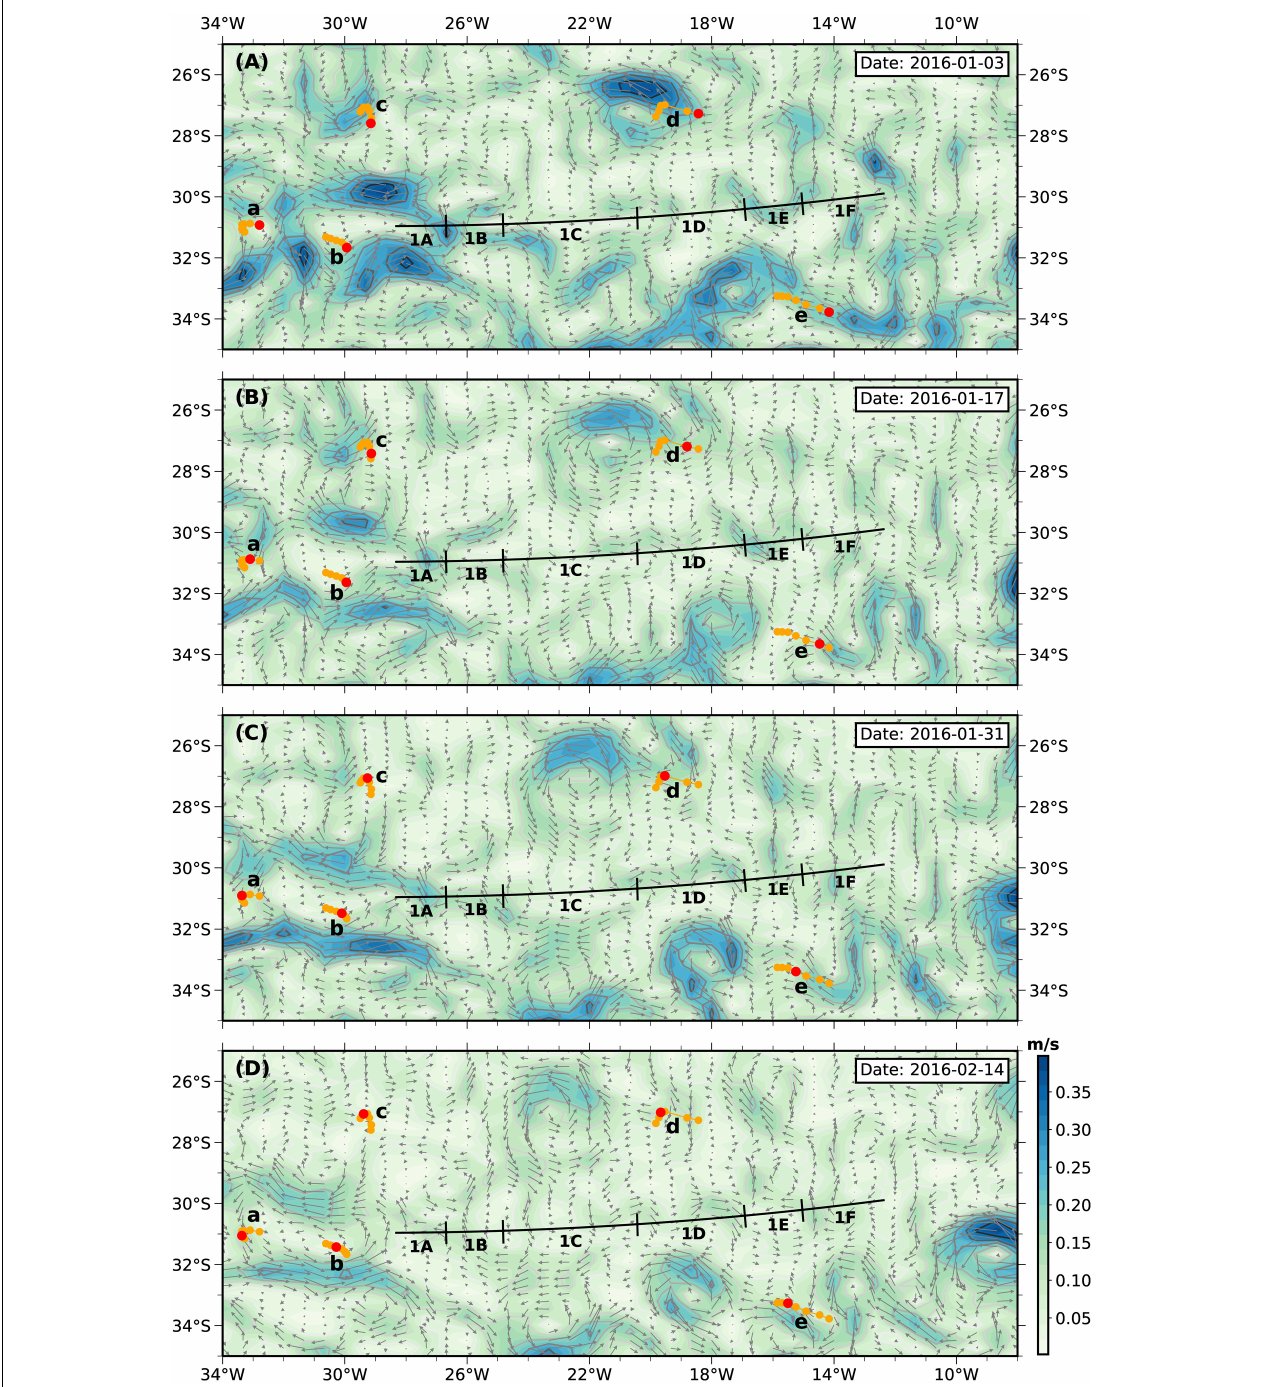
FIGURE 10 | (A) Maps of sea surface geostrophic current velocities calculated for 5 days composite centered on 2016/01/03 from Ocean Surface Current Analyses Real-time (OSCAR) satellite measurements. Black lines = seismic survey lines. Orange dots = the trajectory of the Argo floats a–e shown in Figure 1 . Red dots = the positions of the Argo floats closest to the date of the satellite measurements. (B–D) Same as (A) but separated 2 weeks apart following (A)